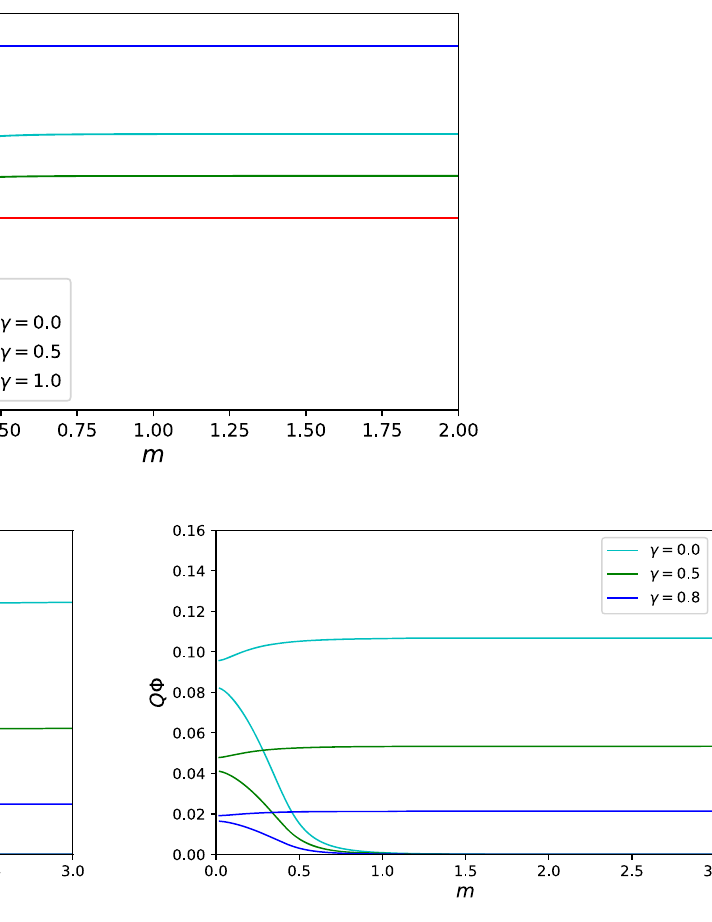
Fig. 3 The upper plot presents δ I δ action growth rate. The mass and electric charge parameters are fixed versus m for the black holes with t as m 0 = 0 . 6 , q = 1 . 5 (lower left plot) or m 0 = 0 . 95 , q = 0 . 8 (lower single horizon. The parameters are fixed as m 0 = 0 . 7 ,(cid:3) = − 1 ,β = 0 . 2 , d = 6 , k = 1 , c 1 = c 2 = c 3 = c 4 = − 1 . 5. The lower two plots right plot), other parameters are fixed as (cid:3) = − 1 ,β = 0 . 2 , d = 6 , k = 1 , c 1 = c 2 = c 3 = c 4 = − 1 . present Q (cid:8) versus m for black holes with inner and outer horizons. For a fixed m , the difference between the upper line and the lower line is